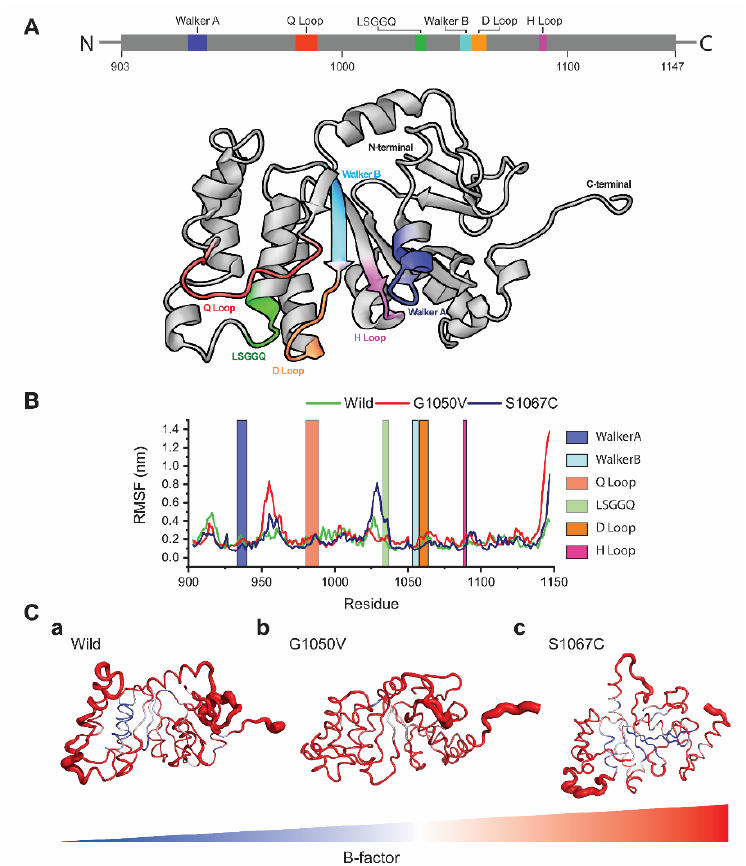
Figure 4. Effects of variants in residual fluctuations. ( A ) Structural representation of the NBD1 domain highlighting the different signature motifs involving in dimeric nucleotide-binding, ATP hydrolysis and TMDs conformational change. ( B ) The root mean square fluctuation (RMSF) plots for both wild and variants types, where green, red, and dark blue line describes wild, G1050V, and S1067C, respectively. ( C ) ( a – c ) Tube representation of the NBD1 domain highlighting the B-factor calculated from the RMSF values. The broader tube with red shades represents the area with high B-factors, while a narrower tube with blue shades indicates residues having low B-factor.